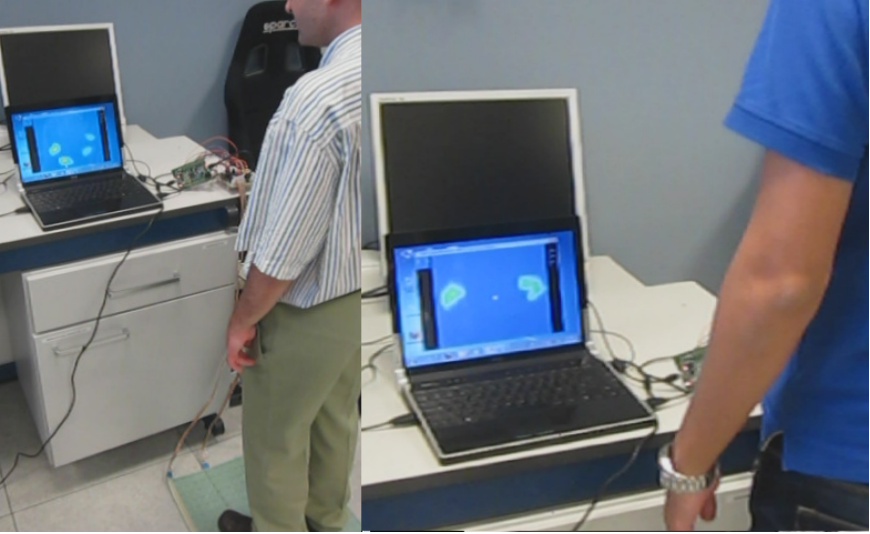
Figure 16. Some users are interacting with the pressure platform